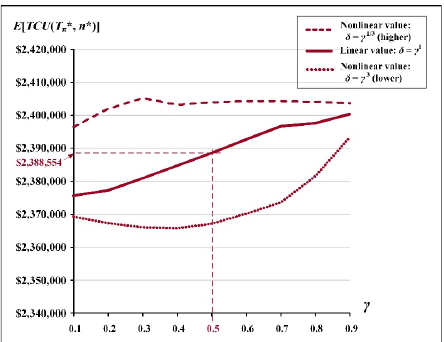
Fig. 15. E [ TCU ( T π *, n *)]’s behavior concerning different relationship δ in terms of γ